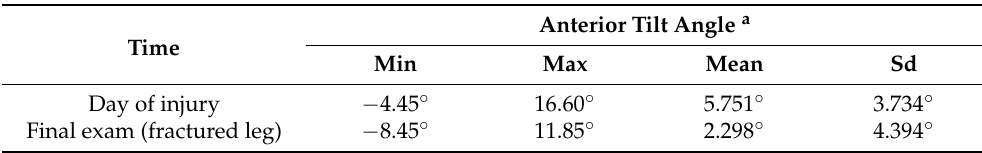
Table 1. Measurements of anterior tilt angles after trampoline fracture in our study population (N = 89) on the day of the injury and one year after trauma.